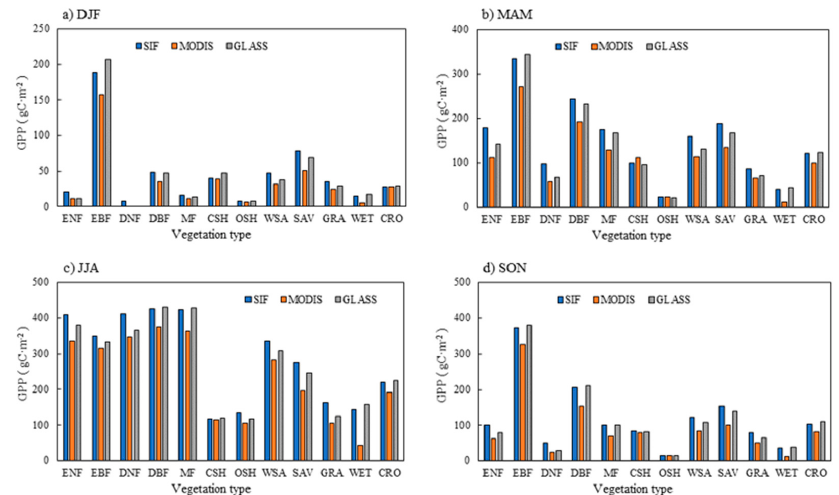
Figure 4. Global GPP for all vegetation coverage types in GPP SIF , GPP MODIS and GPP GLASS in different seasons in 2014.